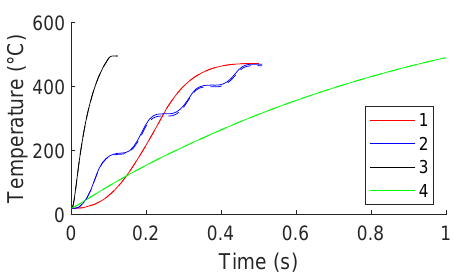
Figure 13. Temperature results of numerical simulation; Temperatures measured at the center of the